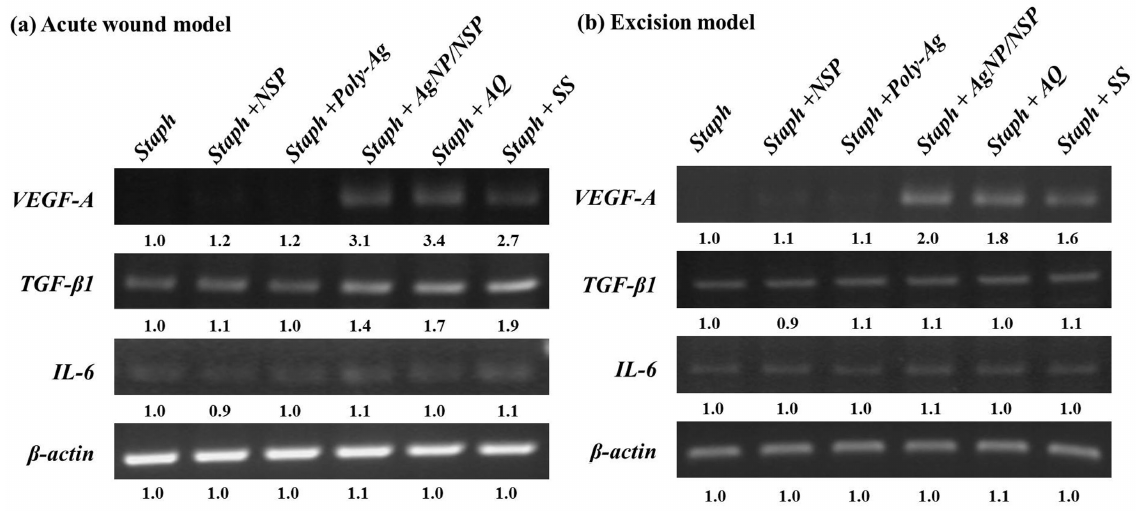
Figure 3. mRNA levels of VEGF-A,TGF- b 1 and IL-6 in different treatment groups during wound healing. AgNP/NSP treatment also modulates the expression of cytokine mRNAs in wounded skin. The levels of VEGF-A , TGF- b 1 and IL-6 mRNA expression from mice of different treatment groups in both acute thermal injury at day 7 (a) and excision wound at day 15 (b) were examined by RT-PCR. Relative band intensities of different groups were calculated by a densitometer and are demonstrated by the values under the bands. The data shown are representative of three independent experiments.